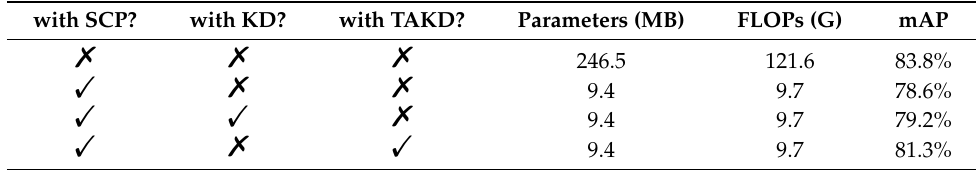
Table 1. Effects of each component on NWPU